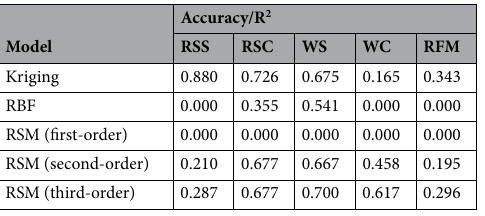
Table 7. Accuracy of the surrogate model by using different